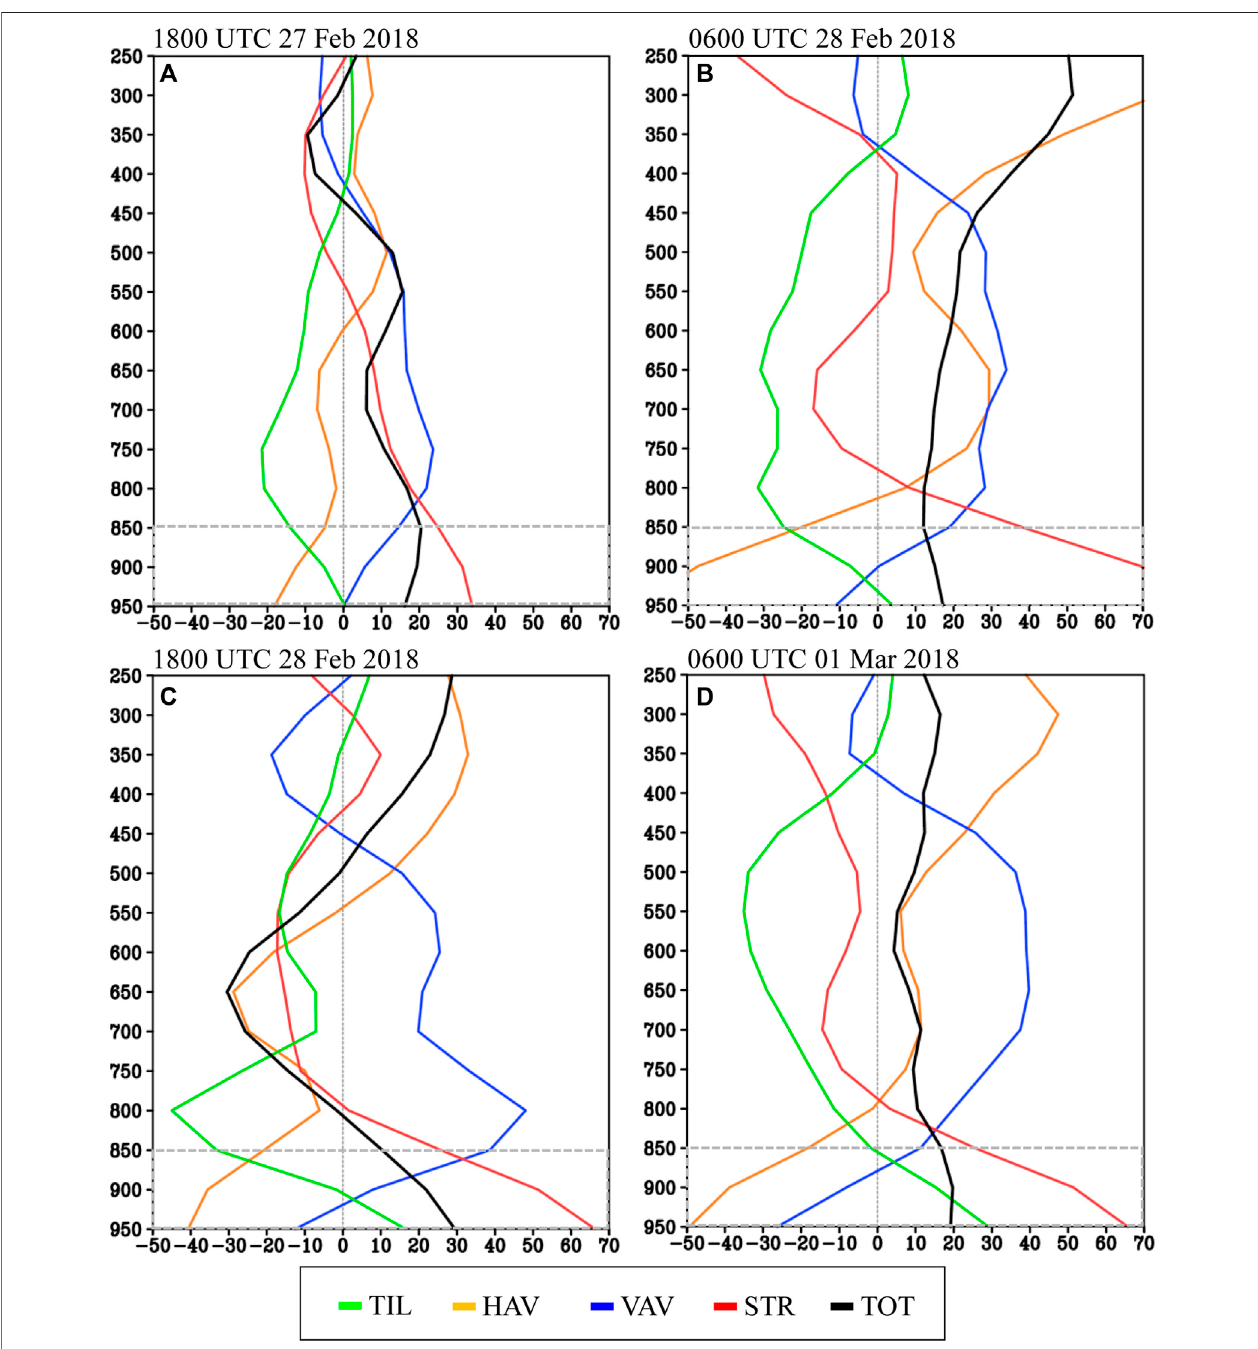
FIGURE4| Central-regionaveragedvorticitybudgetterms(10 -10 s -2 )attypicalstages,wherethegreydashedlinesmarkthevalueof0,andthegreydashedboxes outline the layer of 950-850 hPa. The green lines indicate the tilting effect, the orange lines indicate the horizontal advection of vorticity, the blue lines indicate the vertical advection of vorticity, the red lines indicate the stretching effect associated with divergence, and the blace lines indicate the sum of TIL, HAV, VAV, STR, and APV.